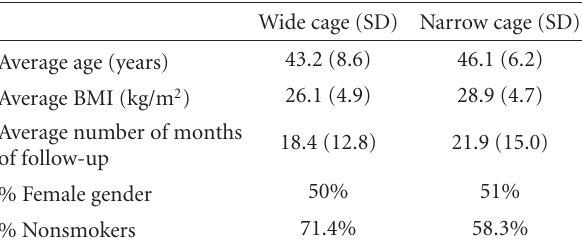
Table 1: Patient characteristics.